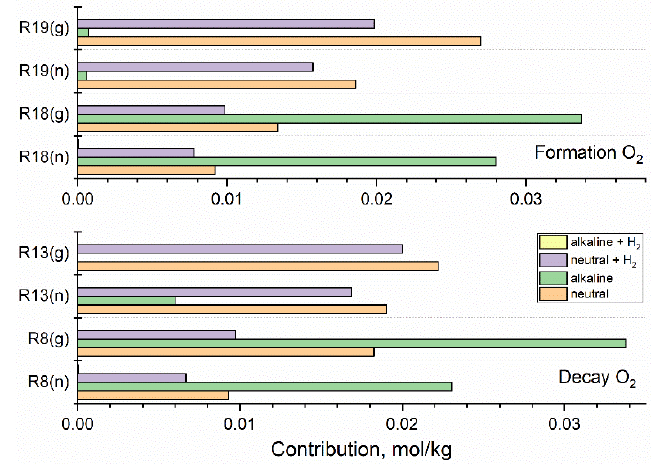
Figure 8. Contribution of key reactions responsible for the formation and decay of O 2 calculated for fast neutron (n) and gamma (g) radiolysis of neutral water, alkaline solution, and hydrogenated (3·10 − 5 mol·kg − 1 H 2 ) neutral and alkaline systems. Based on the simulation for 1 kGy·s − 1 .